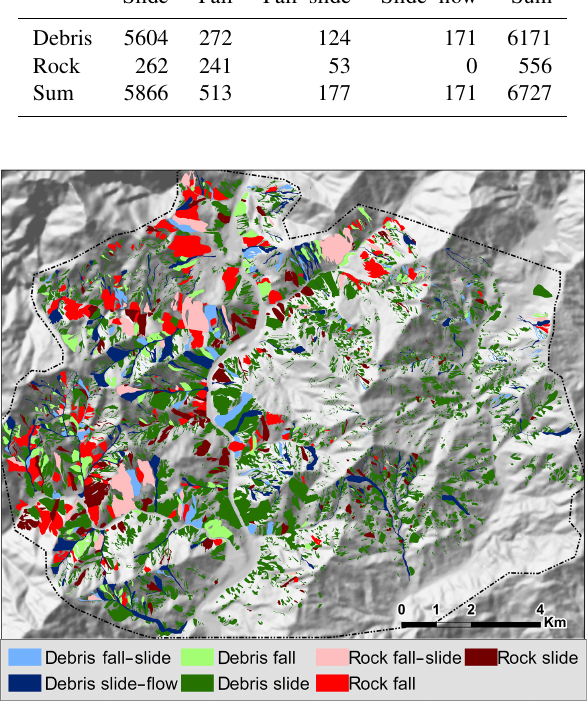
Figure 4. Co-seismic landslide